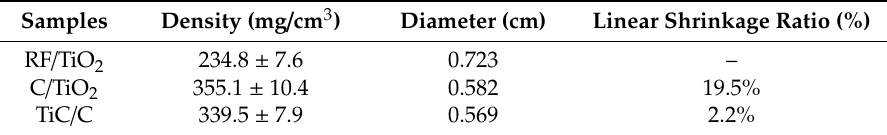
Table 1. Densities and diameters of RF / TiO 2 , C / TiO 2 and TiC / C composite aerogels.